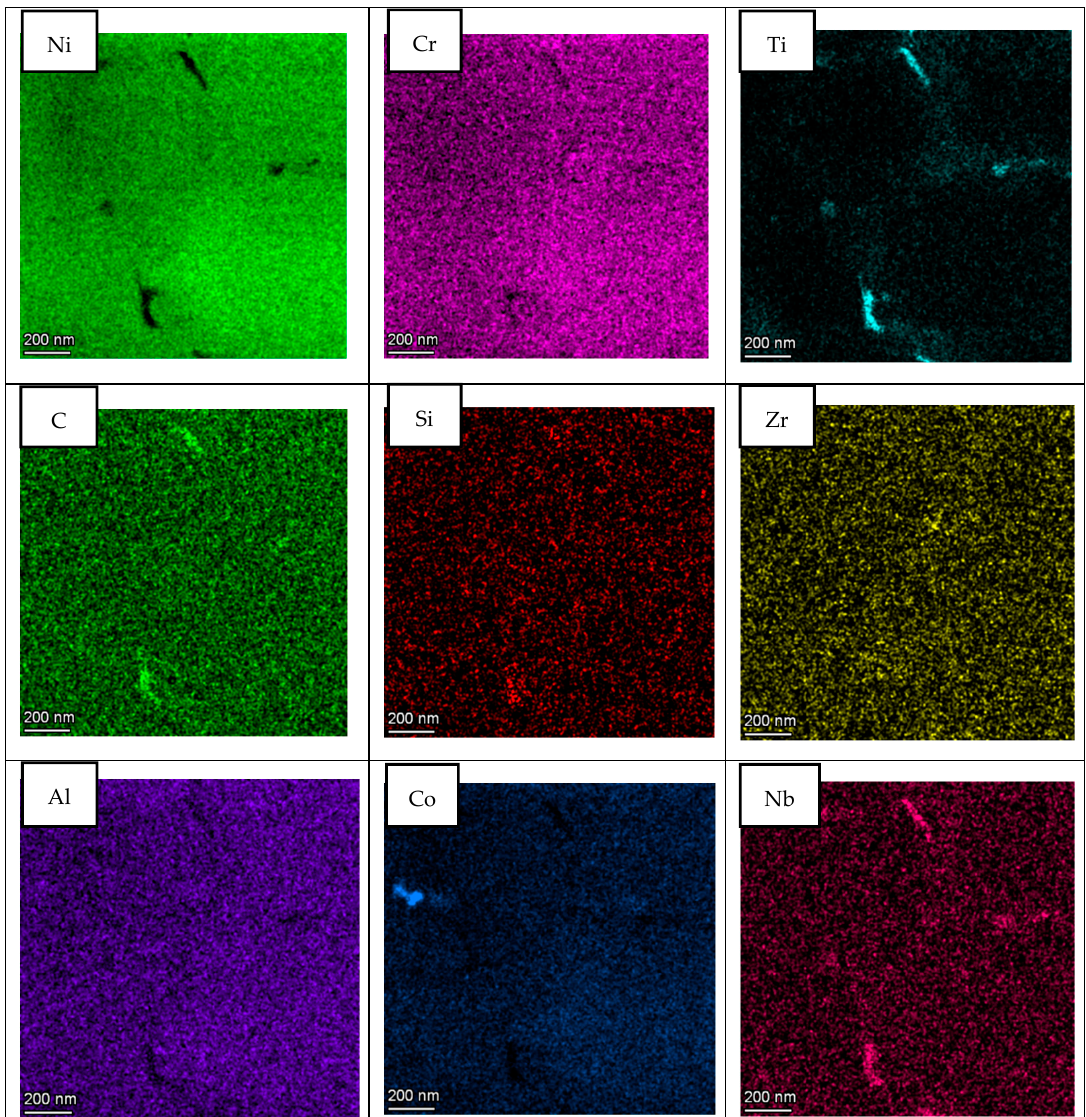
Figure 7. STEM EDS compositional maps of the LPW sample grain boundary.